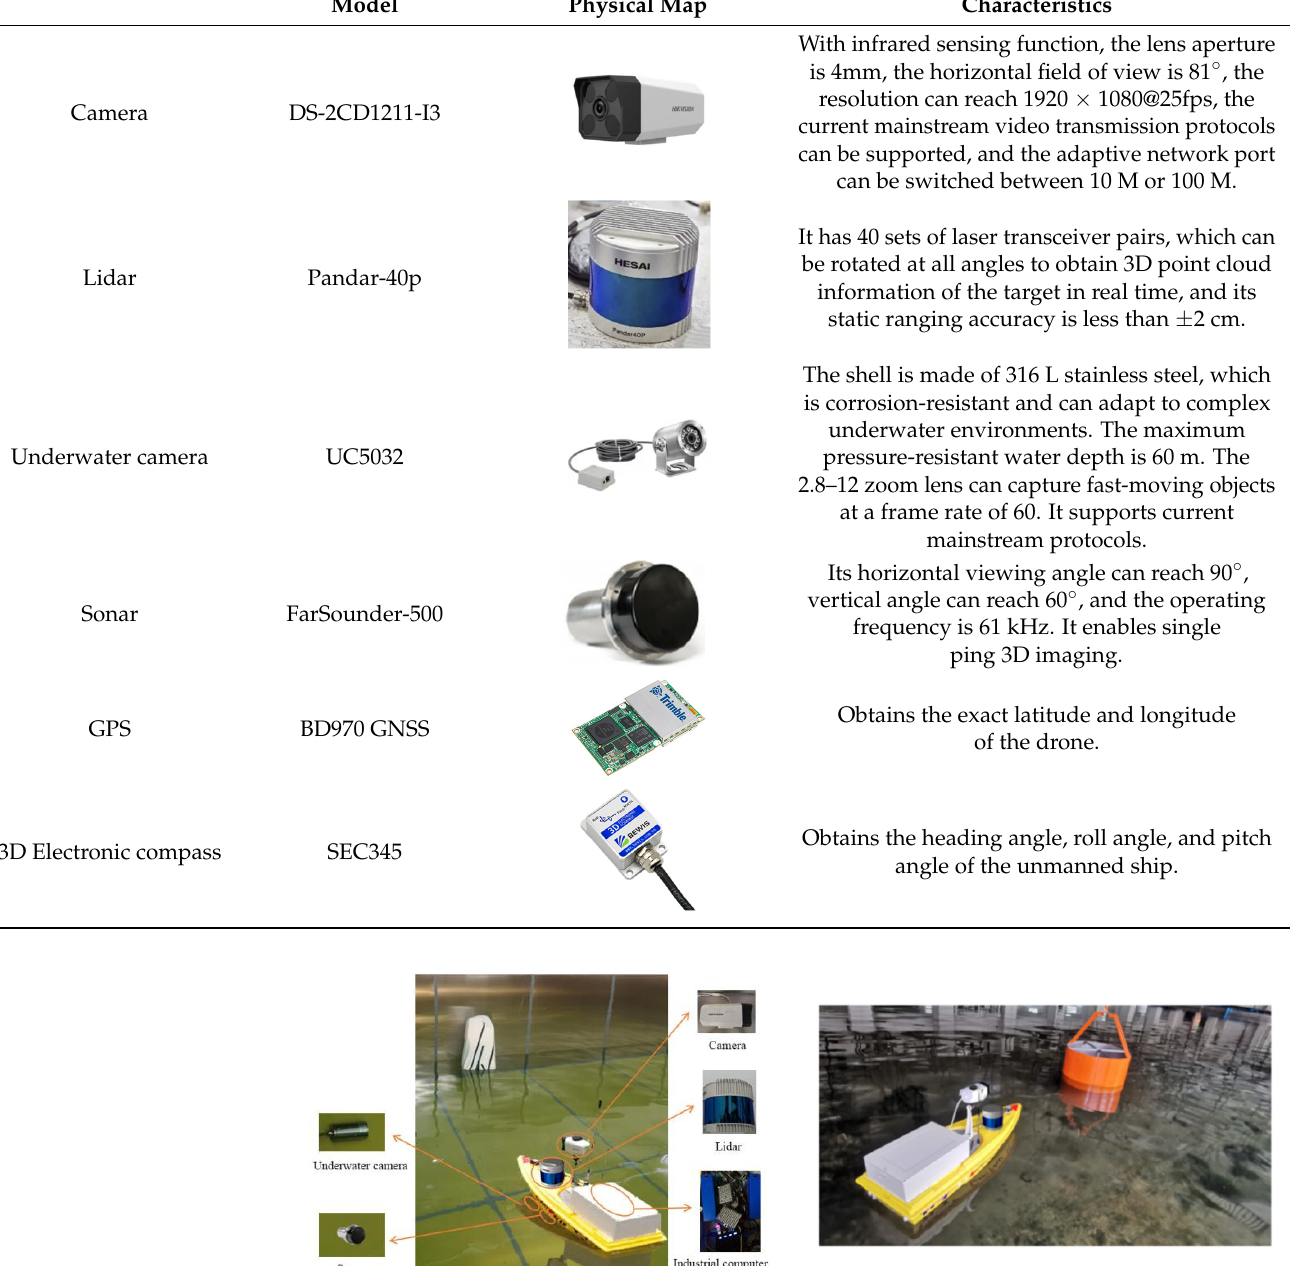
Table 3. The model and characteristics of the equipment.